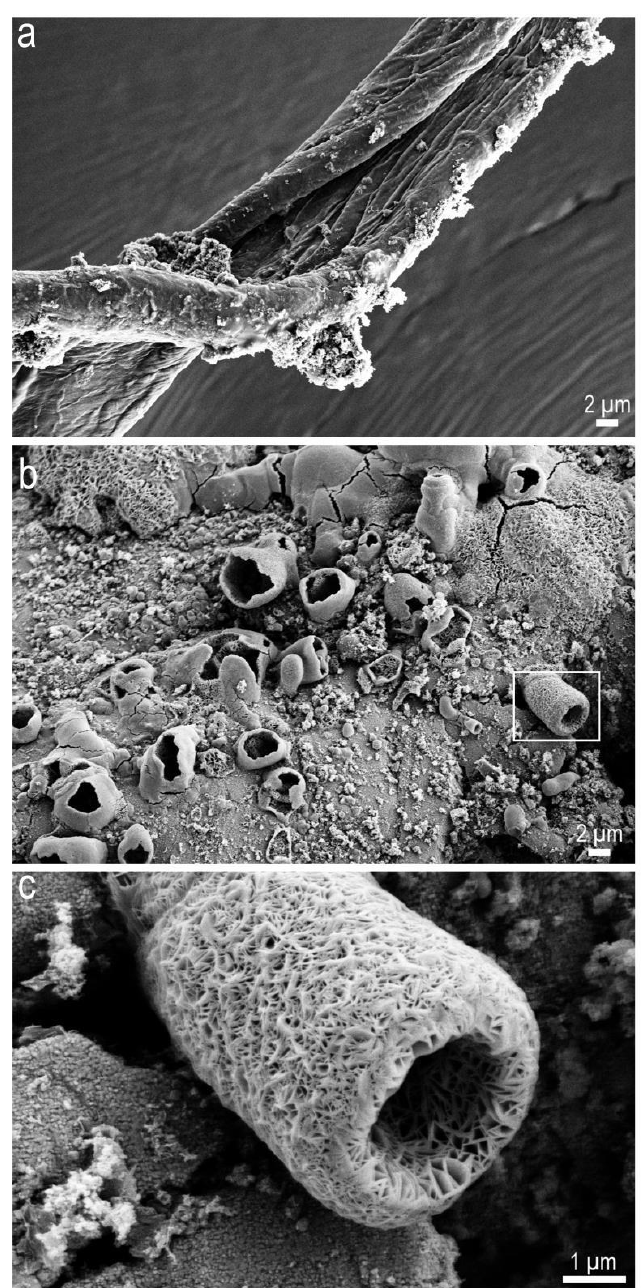
Figure 3. SEM images of residues obtained after shock processing of equal proportions of four amino acids (Table S1). ( a ) Thick thread feature containing fine threads running all along, ( b ) shows many porous features and ( c ) the porous cylindrical feature .